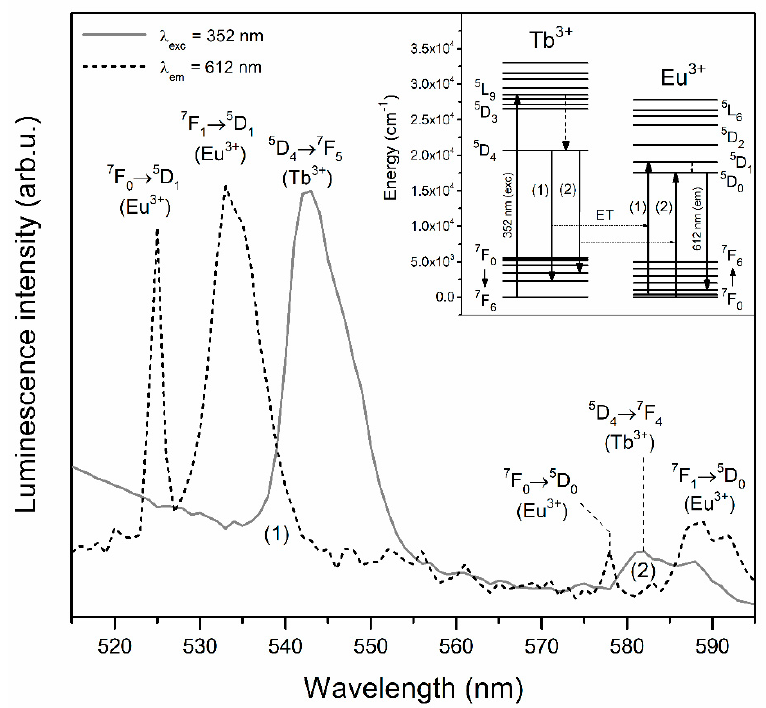
Figure 6. An overlap of Tb 3 + emission ( λ exc = 352 nm) and Eu 3 + excitation ( λ em = 612 nm) regions and illustration of energy levels involved in Tb 3 + → Eu 3 + energy transfer process.